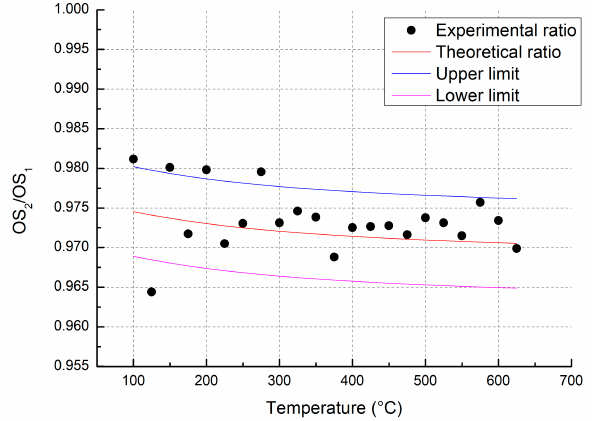
Figure 3. Experimental SR, depleted from the reflection contribution, where a huge variability due to the black body stability and camera sensitivity is shown. The Mathcad simulation with uncertainties is shown [6].